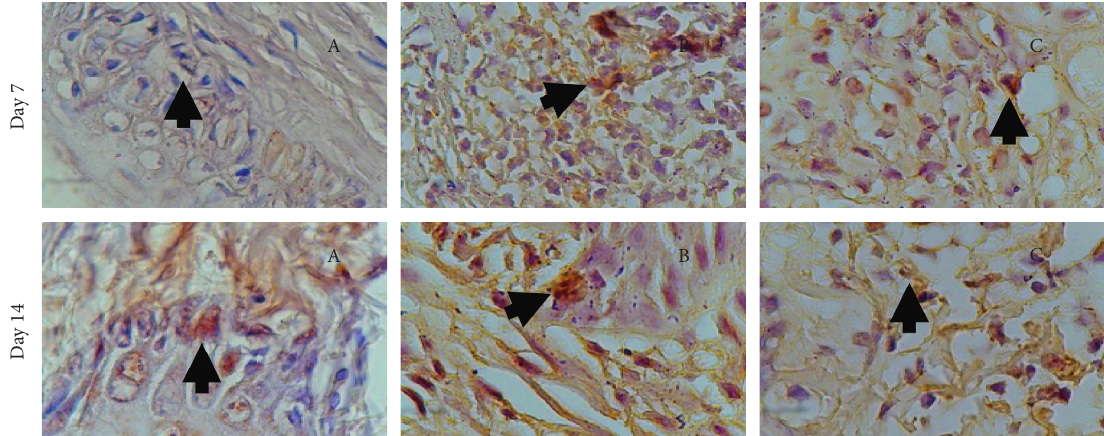
Figure 2: TNF- α expression on the 7th and 14th day. (a) Treatment group: combination of SRP+VCO gel. (b) Positive control group: SRP+ metronidazole gel. (c) Negative control group: